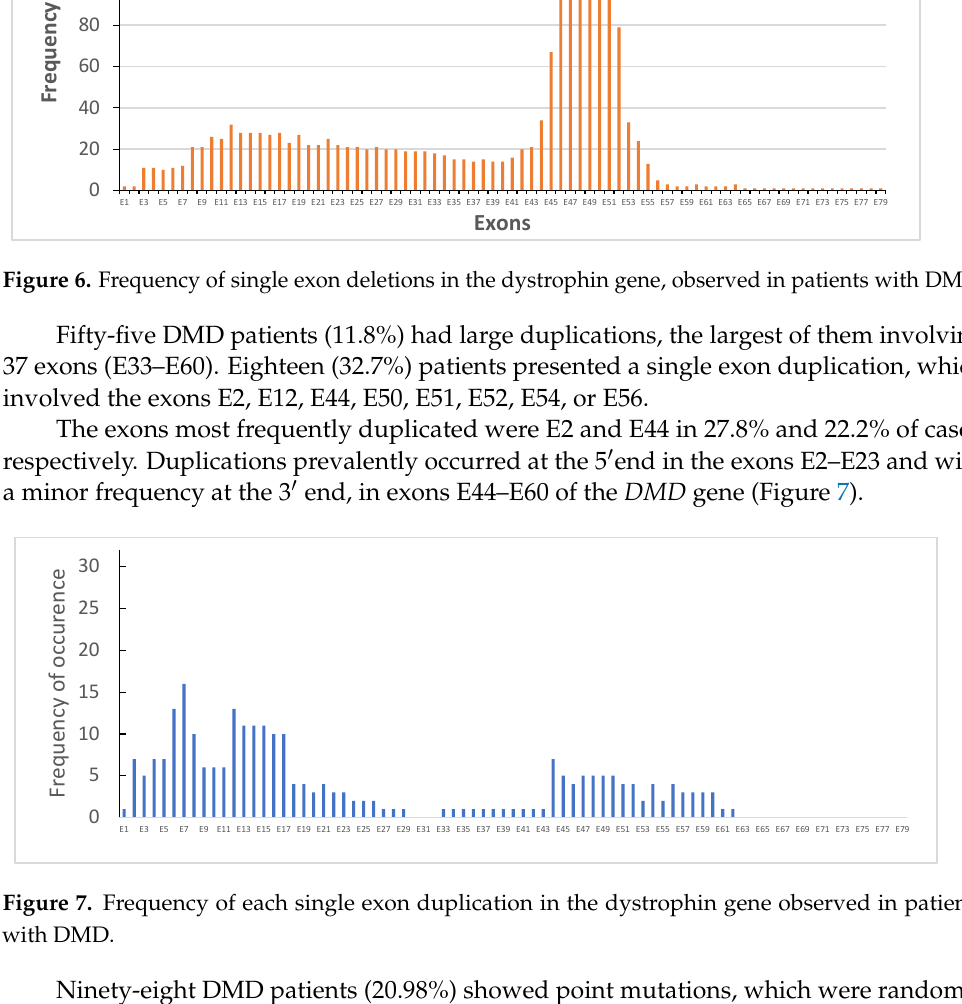
Figure 7. Frequency of each single exon duplication in the dystrophin gene observed in patients with DMD .